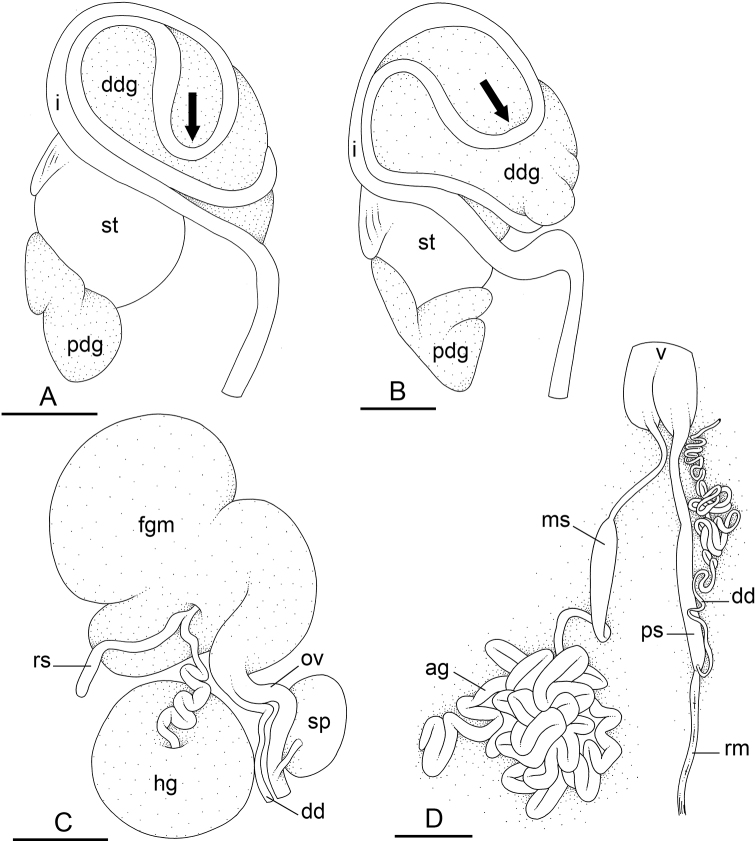
Peronia
verruculata (unit #4) A lectotype, Paraperonia
gondwanae, India, Mumbai (MNHN-IM-2000-33681) B–D Pakistan, [6164] (MNHN-IM-2019-1384) A digestive system, dorsal view, the arrow indicates the orientation of the transitional loop B digestive system, dorsal view C posterior, hermaphroditic (female) reproductive system D anterior, male, copulatory apparatus. Scale bars: 4 mm (A, C), 5 mm (B, D). Abbreviations: ag accessory penial gland, dd deferent duct, ddg dorsal digestive gland, fgm female gland mass, hg hermaphroditic gland, i intestine, ms muscular sac, ov oviduct, pdg posterior digestive gland, ps penial sheath, rm retractor muscle, rs receptaculum seminis, sp spermatheca, st stomach, v vestibule.